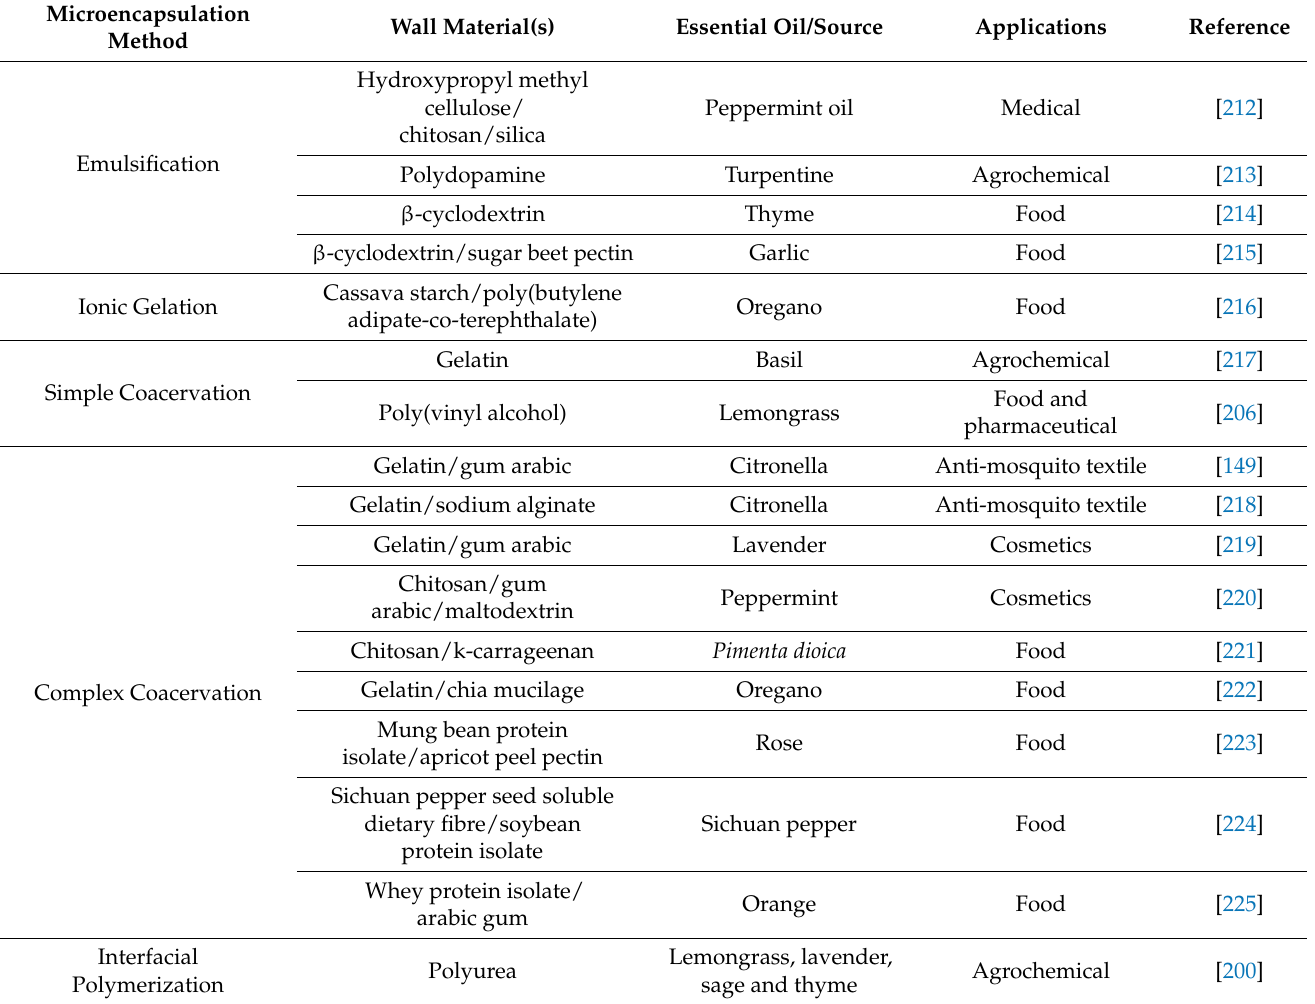
Table 6. Overview of essential oil microencapsulation, methods, wall materials, and industrial ap ‐ plications.